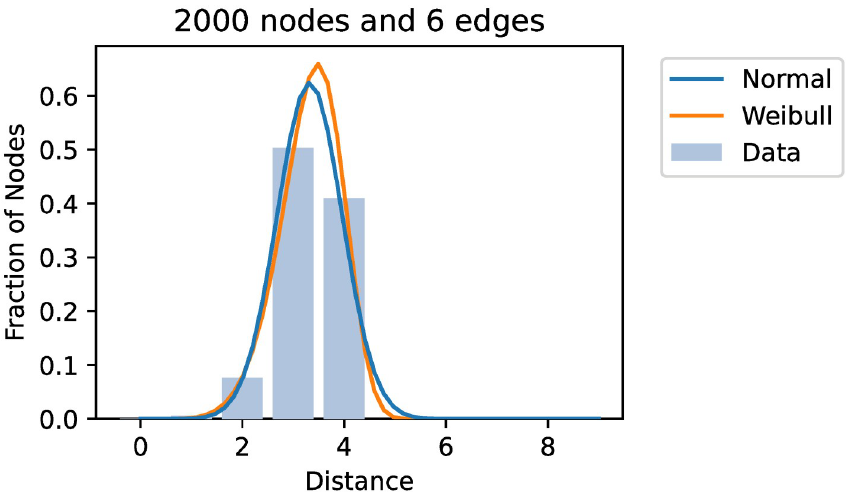
Fig 3. Fitted continuous distributions from an example dataset, which was created using 2000 nodes and 6 edges per node. A lognormal and truncated normal fit were plotted identically to the normal distribution and were, therefore,